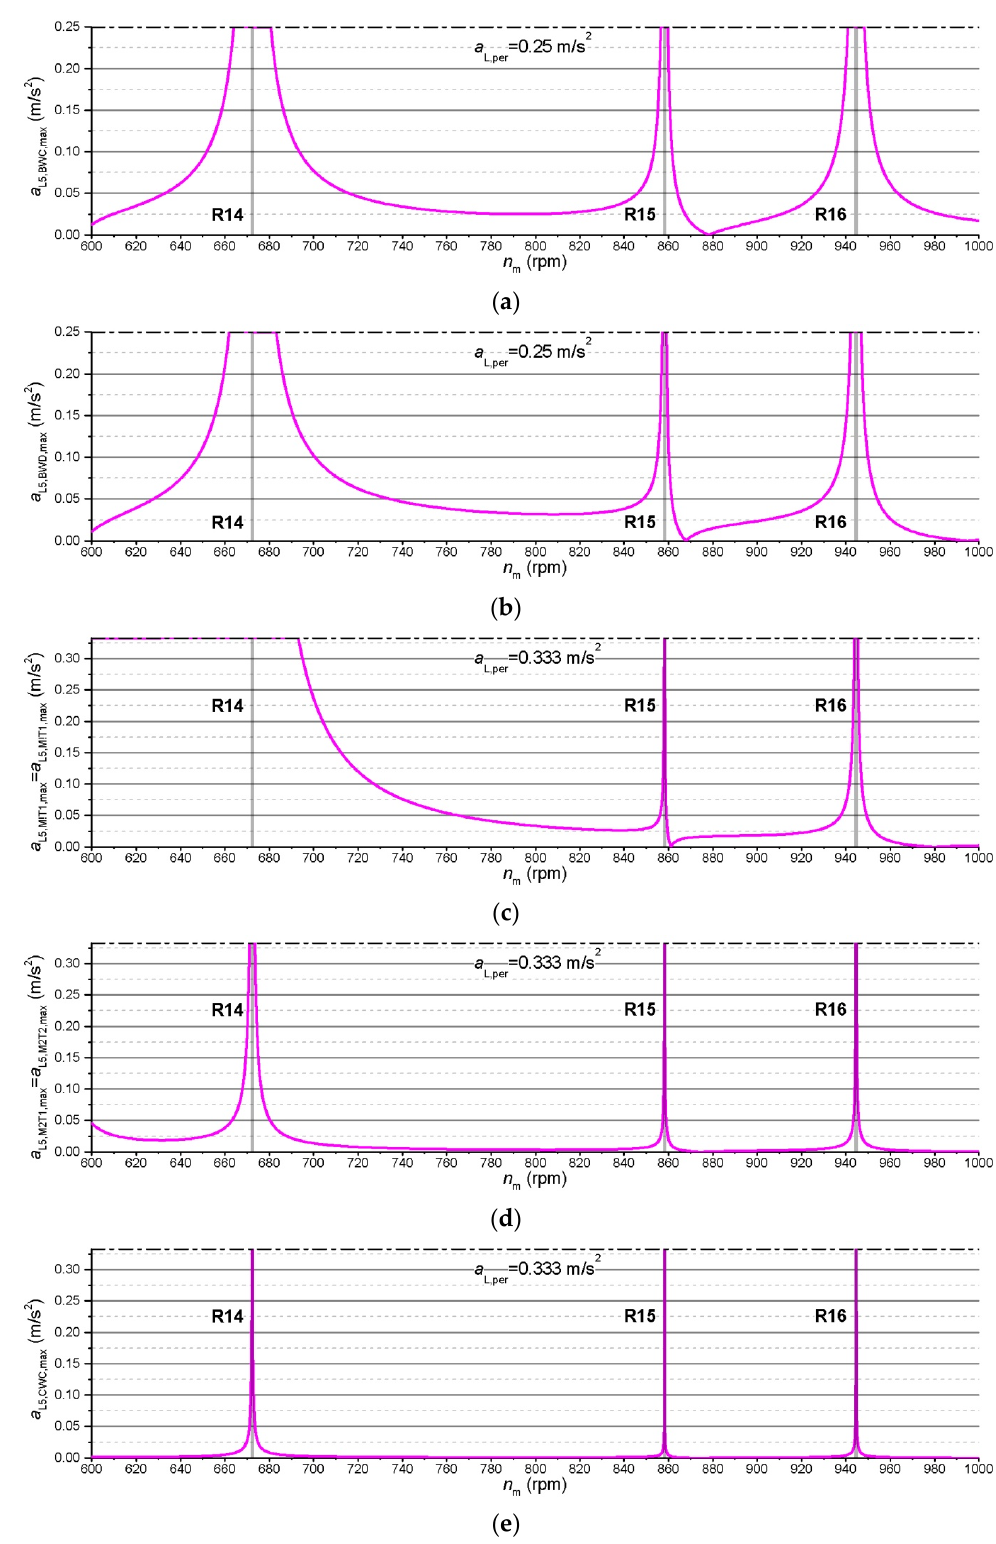
Figure 13. Response to the fifth harmonic of excitation—maximal lateral accelerations of the referent points of the slewing superstructure: ( a ) BWC; ( b ) BWD; ( c ) M1T1 and M1T2; ( d ) M2T1 and M2T2; ( e ) CWC. Table 5. Boundaries of the FREM resonant domains according to a V,per –EHO: 1.